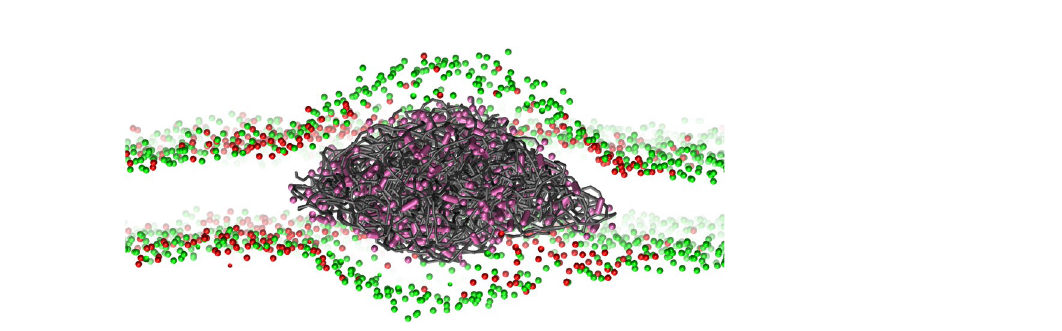
Figure 5. PE in the ternary mixture of DPPC, DIPC and cholesterol. Bi-dimensional maps of the ( a ). PE density, ( b ). Membrane thickness and ( c ). Lipid tails order parameter.